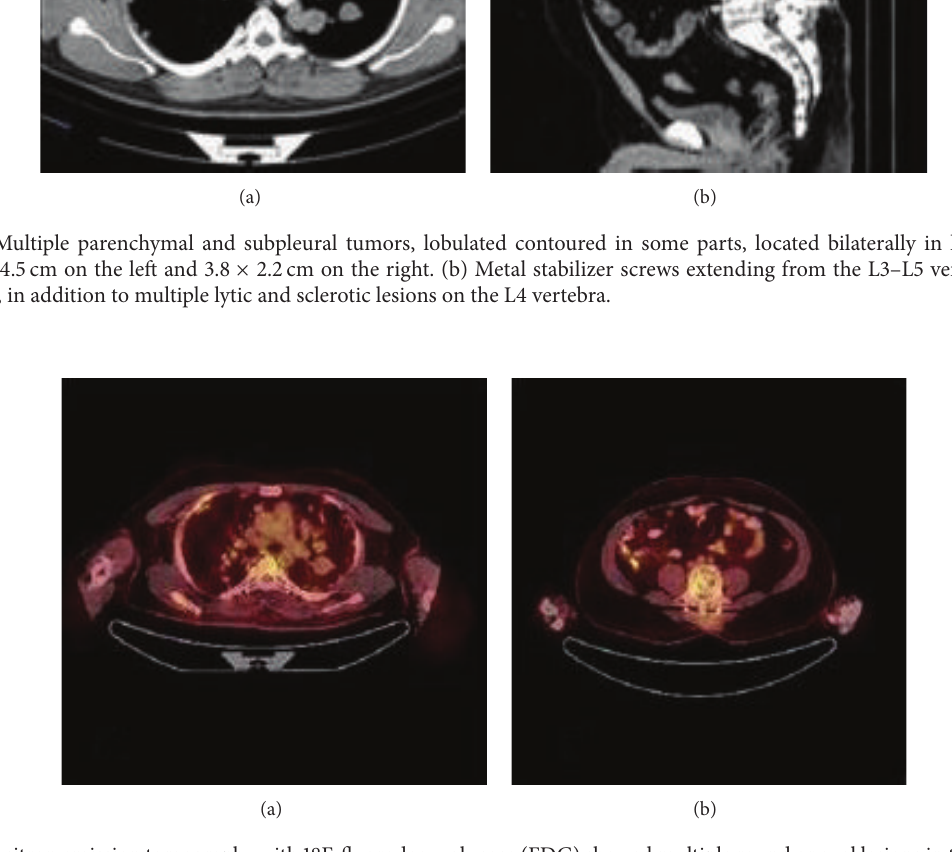
Figure 3: (a) Positron emission tomography with 18F-fluorodeoxyglucose (FDG) showed multiple round or oval lesions in the lung, (b) FDG uptake in midportion of L1-L2, L3 vertebral